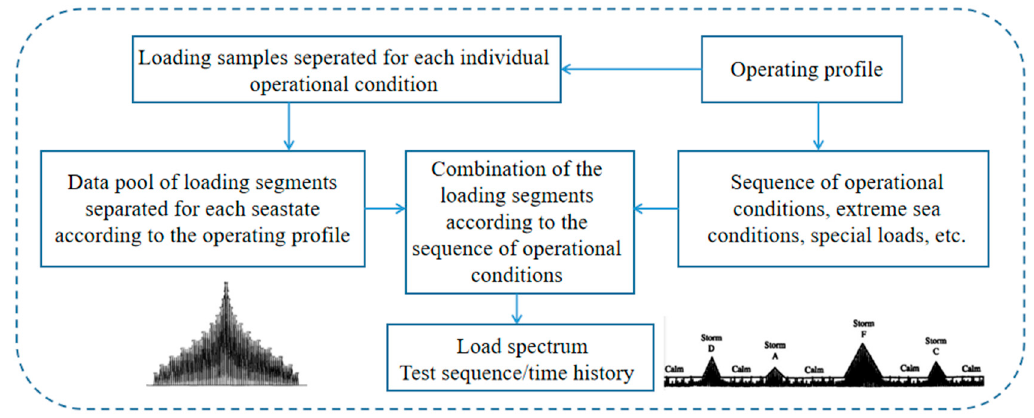
Figure 5. General approach for the generation of standardized loading histories (SLHs) [18].